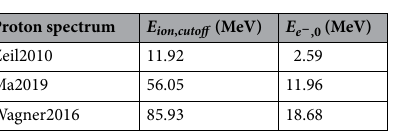
Table 2. Summary of proton cutoff energies and electron temperatures of the particle spectra used.